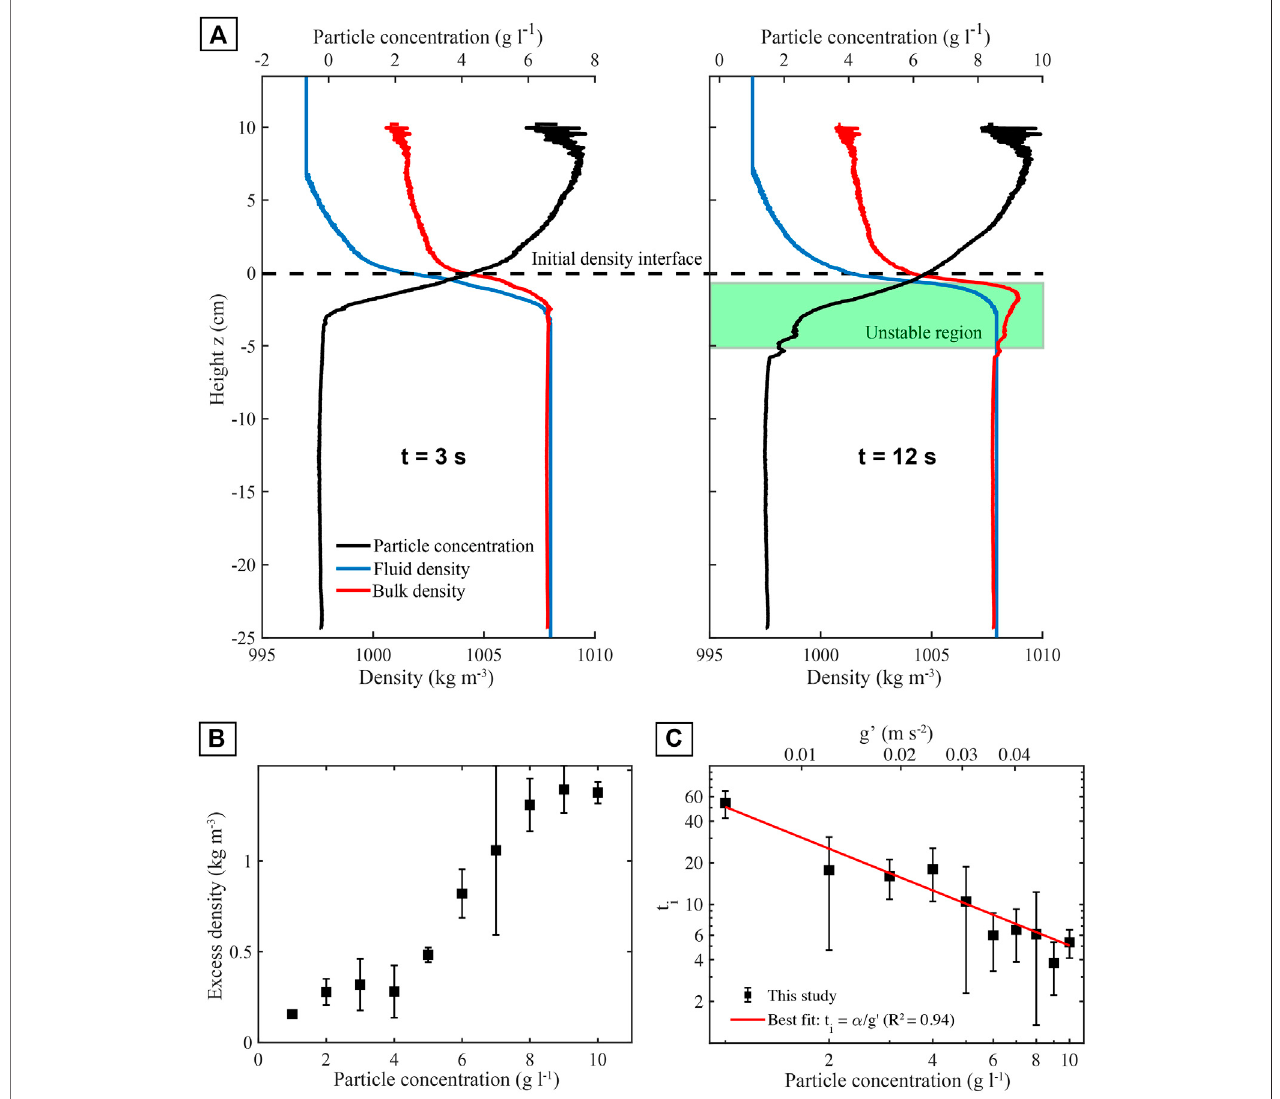
FIGURE 6 | (A) Horizontally-averaged density and particle concentration pro fi les for experiment A8 (initial particle concentration is 8 g l − 1 ; Table 2 ), with the fl uid phase density in blue, the particle concentration in black (axis above) and the bulk mixture density in red. The initial barrier position is represented by the dashed lines. Initially,at t (cid:2) 3 s (leftpanel) ,thebulk strati fi cation isstable.After sometime t (cid:2) 12 s (right panel) , thePBL develops below theinterface and leadstothe formationofa dense unstableregion highlighted ingreen. Forclarity, theuncertaintiesassociated withmeasurementsofthe fl uid density (correspondingto0.8 kg m − 3 belowthe density interface) are not displayed on the fi gures. (B) Variation in the excess density with particle concentration for experiments A1 – A10 ( Table 2 ). The particle concentrationonthehorizontalaxisreferstotheinitialparticleconcentrationoftheupperlayer,whereastheexcessdensityisthemaximumvalueforagivenexperiment. (C) Effect of particle concentration on the duration t i required to attain an excess density ≥ 0.15 kg m − 3 in the upper layer. Error bars correspond to the standard deviation associated with each particle concentration.